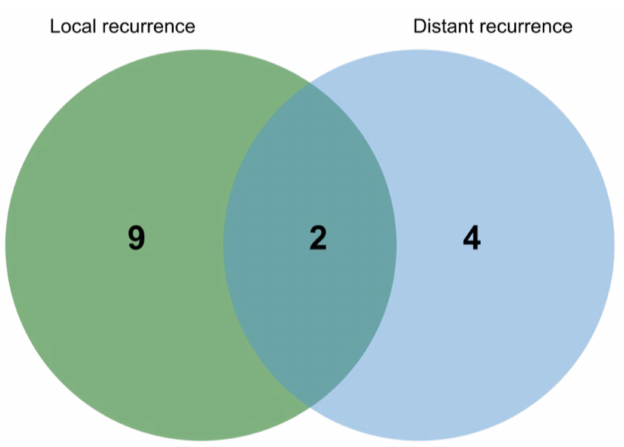
Figure 2. Distribution of recurrences without distant metastases at initial